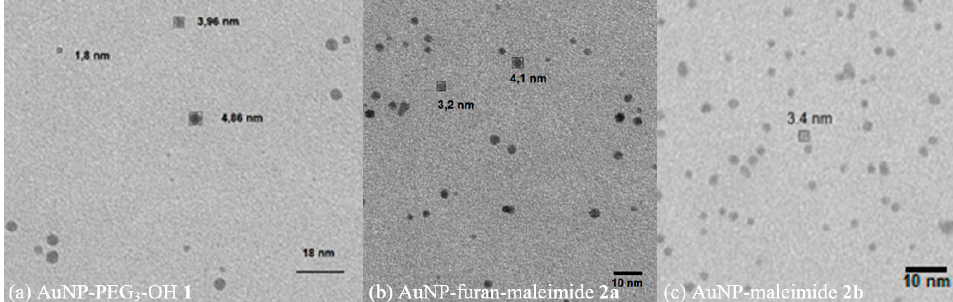
Figure A10. Transmission electron microscopy of ( a ) AuNP-PEG 1 (A = 10.53 nm 2 , Ø = 3.66 nm, n = 1000), ( b ) AuNPs 2a , and ( c ) AuNPs 2b (A = 9.21 nm 2 , Ø = 3.42 nm, n = 1860).